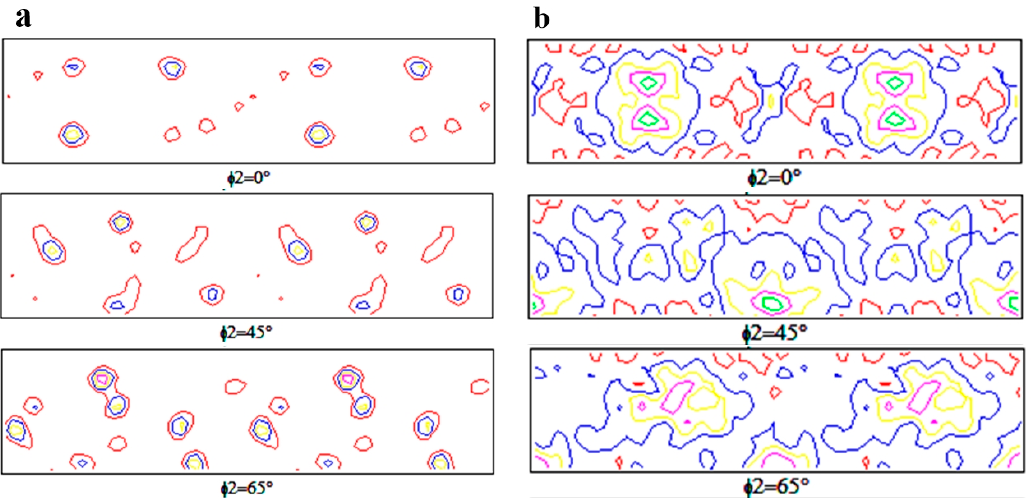
Figure 5. Orientation distribution functions (ODFs) of ( a ) AA2219 alloy and ( b ) 5 wt.% nanosized TiB 2 /AA2219 composite.